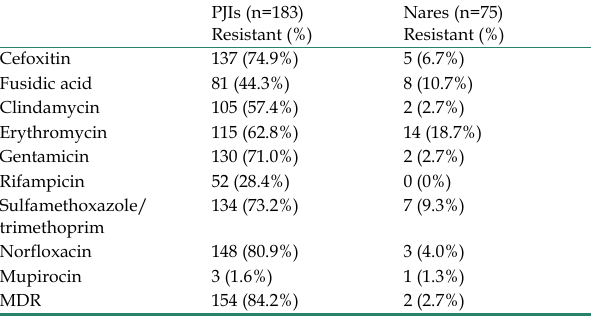
Table 1. Antibiotic susceptibility testing of S. epidermidis isolates obtained from prosthetic joint infections (PJIs) and from nares of patients intended for elective arthroplastic surgery. Multi-drug resistance (MDR) was defined as resistance against ≥3 antibiotic